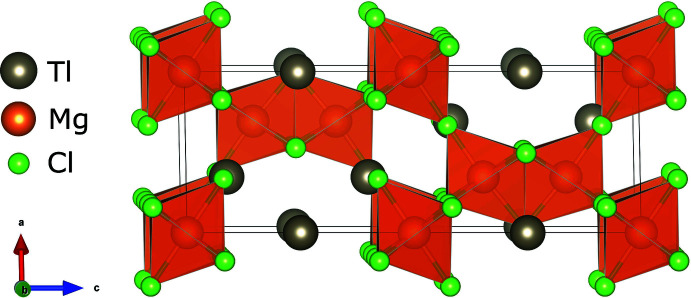
The unit cell of TlMgCl3, with the MgCl6 octa­hedra shown in polyhedral representation.